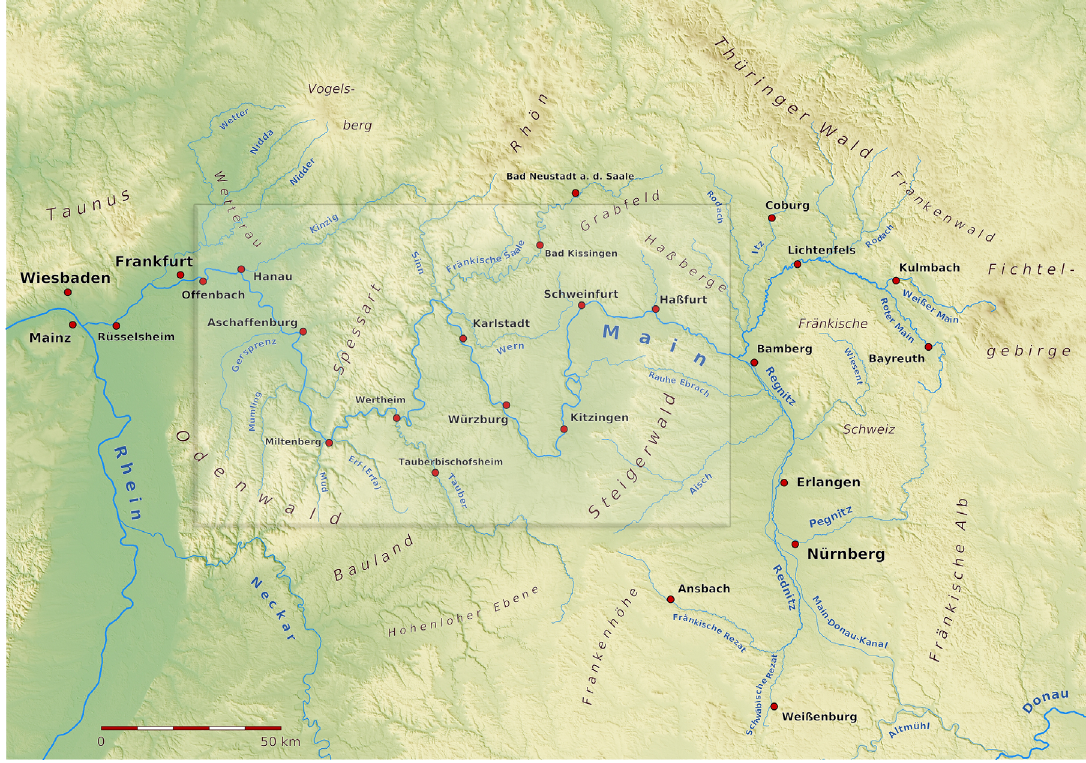
Figure 1. Location of the area under investigation at the Main River in southern Germany (open-source image with alterations by